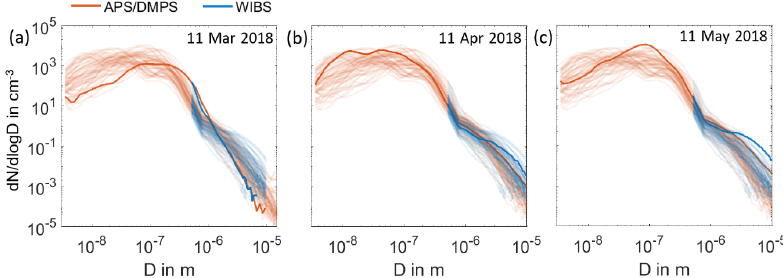
Figure A3. Aerosol size distributions measured by DMPS and APS and WIBS. The daily size distributions of atmospheric aerosol particles measured by DMPS and APS (red) are compared to the daily size distribution of atmospheric aerosol particles measured by WIBS (blue) in the period from 11 March to 13 May 2018. In panels (a) , (b) and (c) , one size distribution in March, April and May is